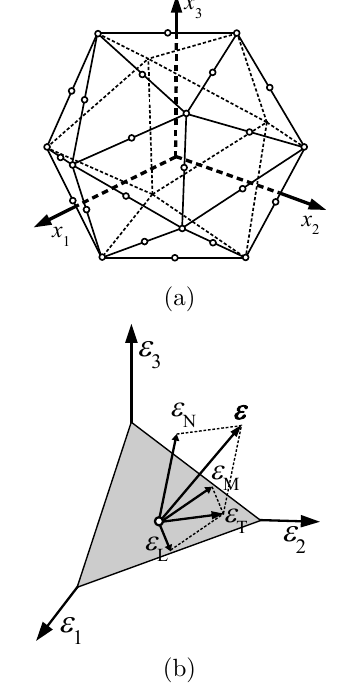
Figure 1. Microplane model: (a) distribution of integration points (microplane normals) - system of 21 microplanes per hemisphere; (b) microplane strain